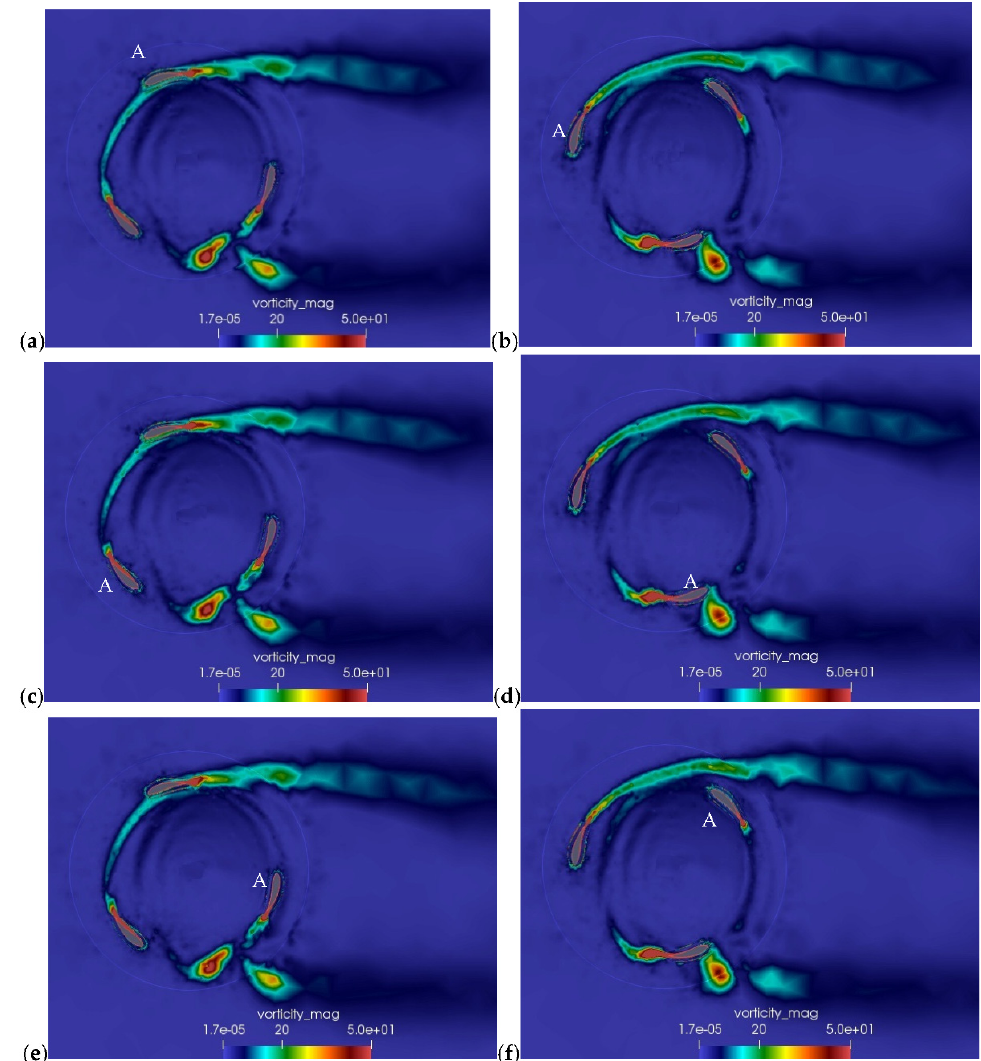
Figure 10. Instantaneous vorticity field for SM at TSR = 2 and different azimuthal angles: ( a ) 15°, ( b ) 75°, ( c ) 135°, ( d ) 195°, ( e ) 255°, ( f ) 315°.